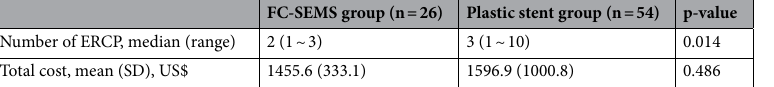
Table 4. Comparison of number of procedure and cost analysis. Abbreviations: FC-SEMS, fully covered self- expandable metal stent; ERCP, endoscopic retrograde cholangiopancreatography.